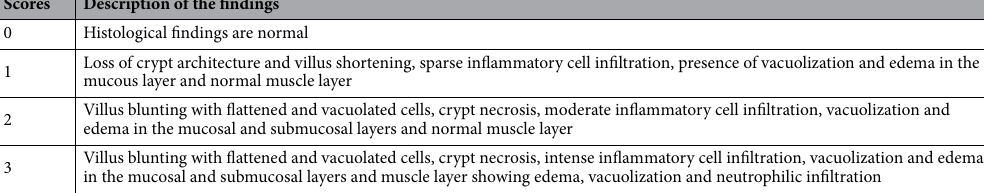
Table 2. Histopathological grading scores. Source: Adapted from Leitão et al.